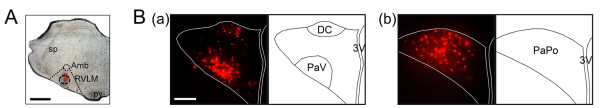
Retrograde labeling of PVN-RVLM neurons. A, RVLM injection site was verified with serial medulla slices including RVLM (100 μm thickness). The representative image shows that a fluorescent spot was confined to the triangular frame defined as RVLM [29]. Amb, nucleus ambiguus; sp, the spinal trigeminal nucleus; py, pyramidal tracts; scale bar = 1 mm. B, the fluorescent image illustrates that the labeled PVN-RVLM neurons were located in the medial region (a) and in the posterior region (b) of the PVN in the hypothalamic brain slices (300 μm thickness). The PVN-RVLM neurons are evident primarily in the dorsal cap (DC), the ventral parvocellular (PaV), and the posterior parvocellular (PaPo) subdivisions. 3 V, the third ventricle; scale bar = 200 μm.